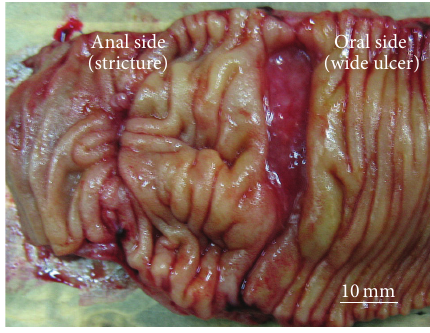
Figure 4: Resected lesion showed double ulcers. There was a wide ulcer at the proximal side of the ulcer scar.